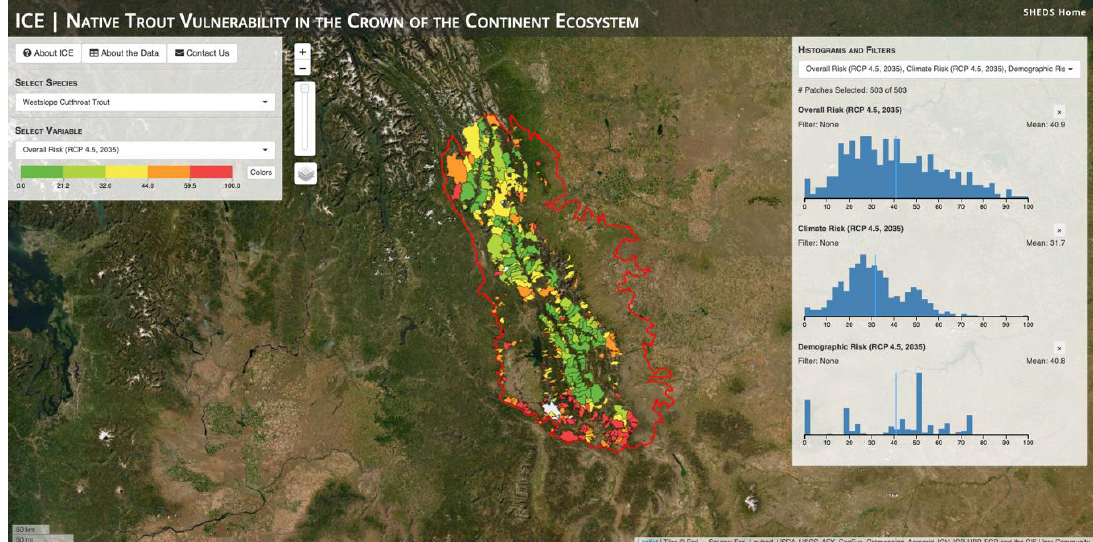
Figure 7. Screenshot of the ICE web application for a climate change vulnerability assessment of native trout species in the Crown of the Continent Ecosystem showing the overall risk of each conservation population for westslope cutthroat trout and crossfilters for the overall risk, climate risk and demographic risk based on the Representative Concentration Pathway (RCP) 4.5 climate scenario projection for the year 2035. Available at http://ice.ecosheds.org/cce/.